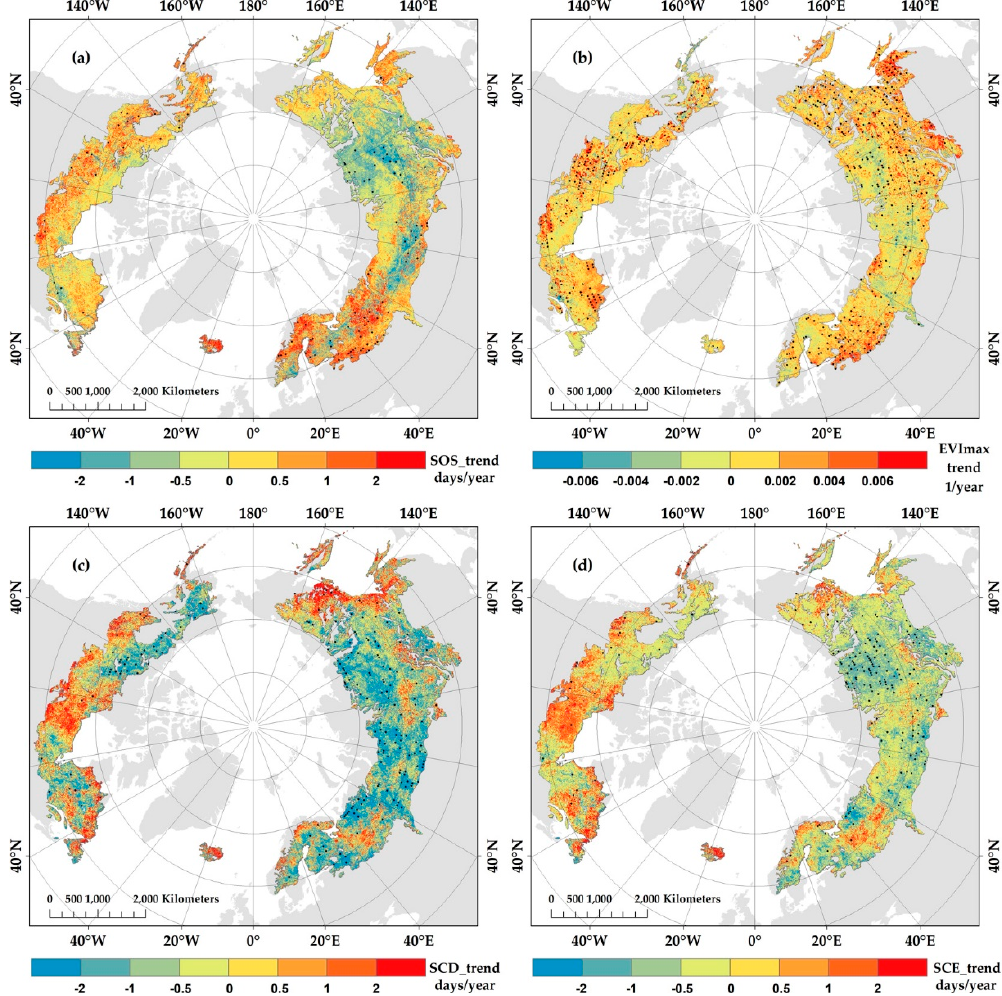
Figure 3. Spatial distributions of the temporal trends in ( a ) the start of the growing season (SOS), ( b ) annual maximum enhanced vegetation index (EVI max ), ( c ) snow cover duration (SCD), and ( d ) snow cover end date (SCE) over the boreal region. The dotted regions indicate that the trends were significant at the 95% level.